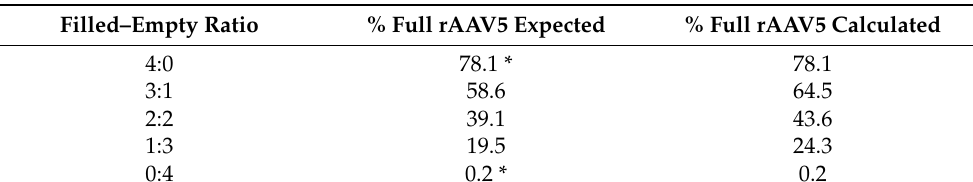
Table 4. Full–empty ratios with expected and calculated percentage of full AAV. * As previously calculated starting materials.